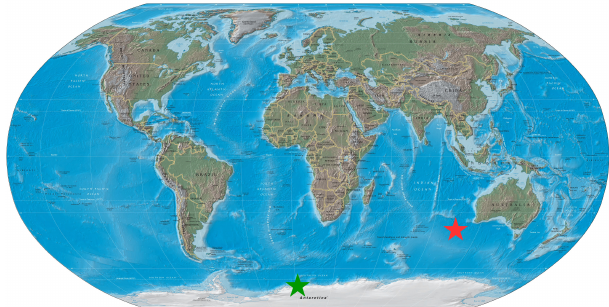
Figure 1: Sampling location of the ocean sediment (ANU) and the Antarctic snow (TUM) represented by a red and green star, respectively. Figure modified from